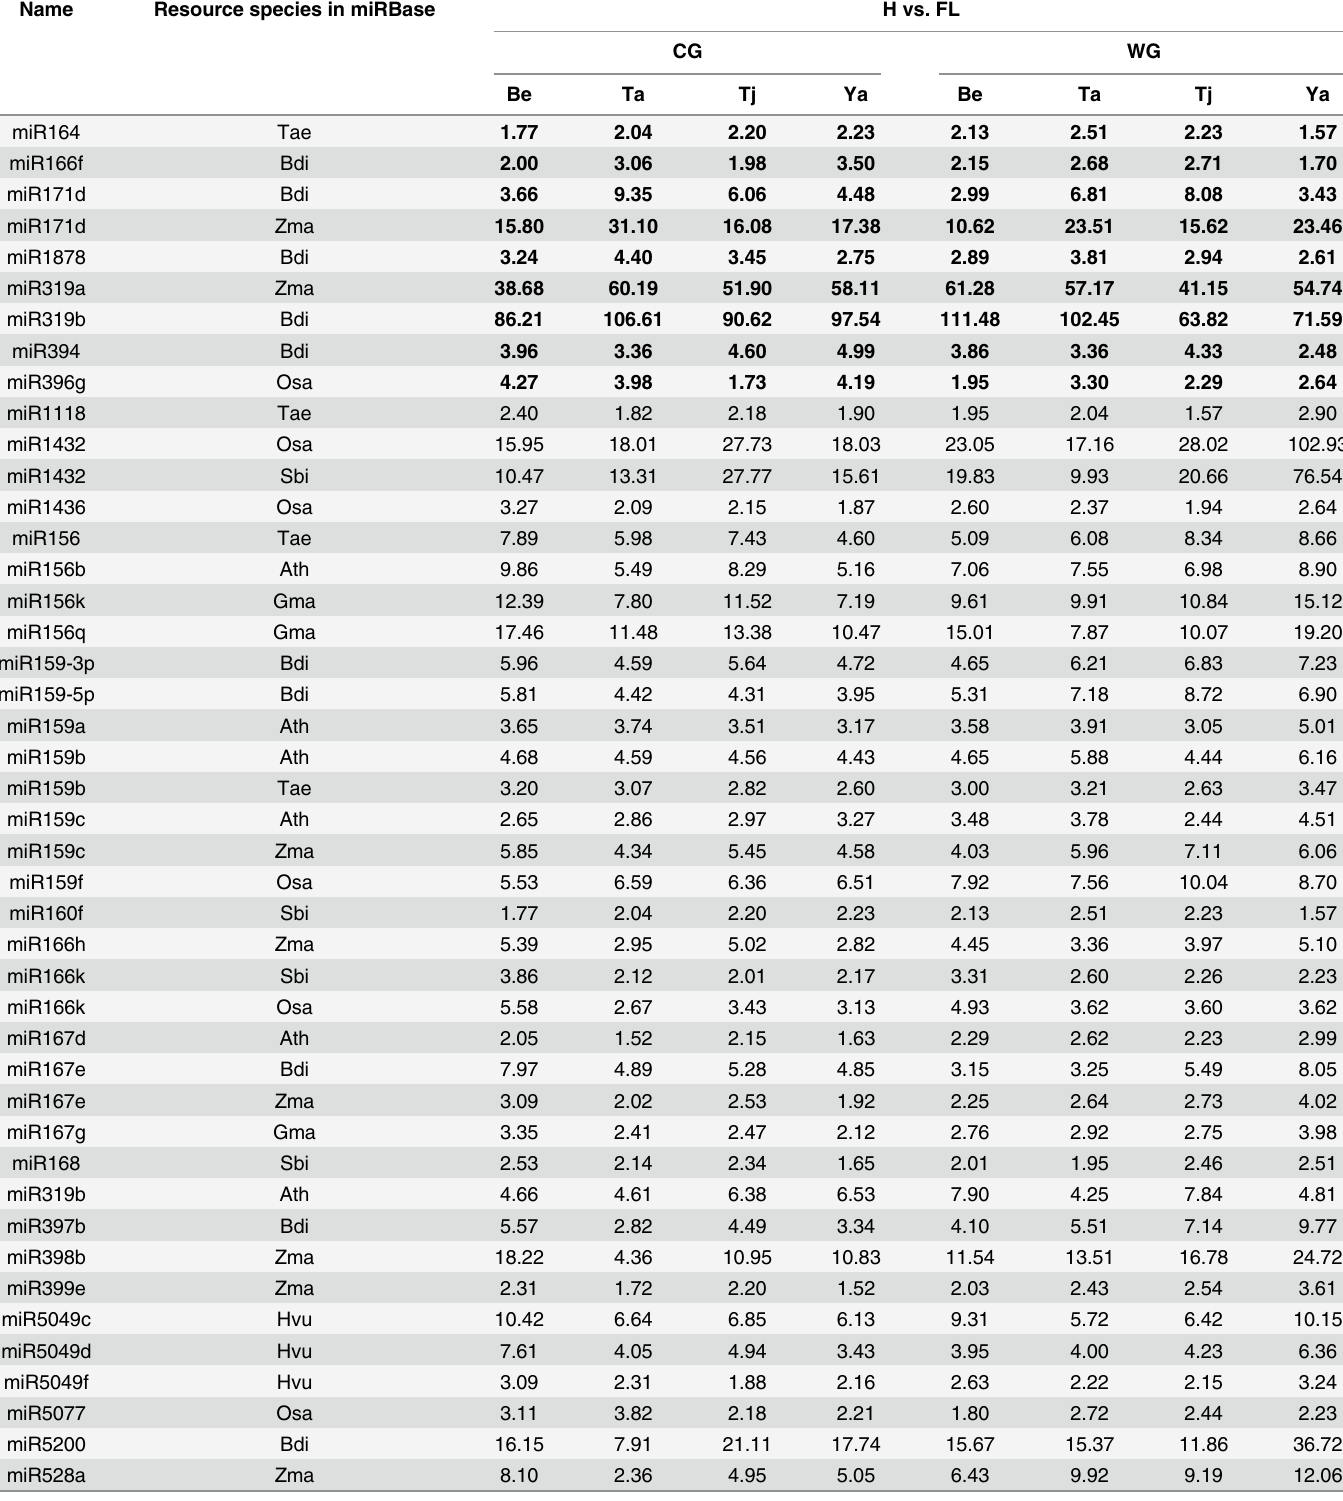
Table 4. Durum miRNAs showed tissue-specific expression profiles regardless of water deficit